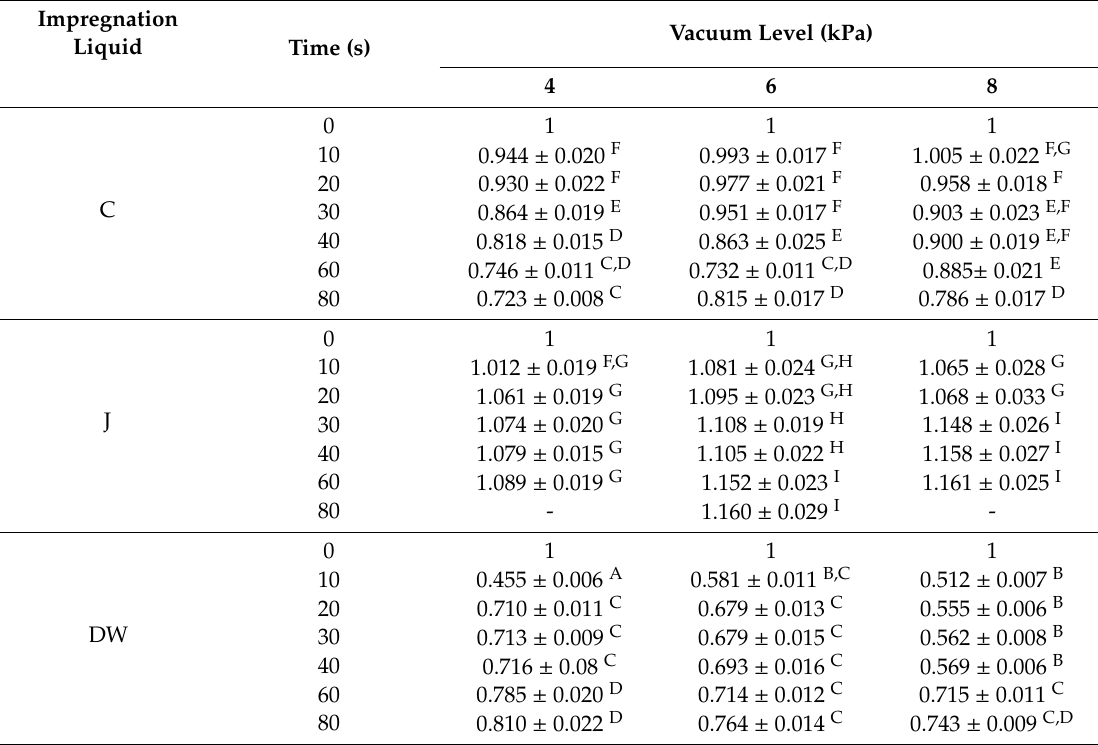
Table 2. Dry mass variation (DMV) during VI of apples at varied vacuum pressures of 4, 6, and 8 kPa using citric acid solution (C), apple-pear juice (J), and distilled water (DW) as the impregnating